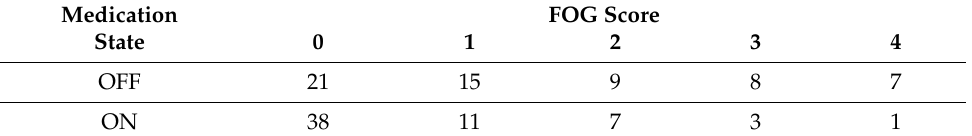
Table 2. Summary of timed-up-and-go testing sessions stratified by medication state and FOG score. Medication FOG Score State 0 1